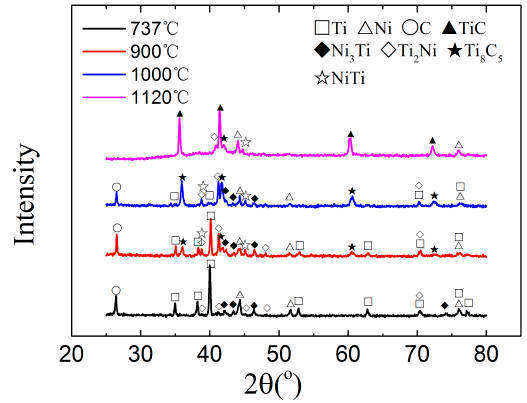
Figure 4. XRD patterns of sintered green bodies quenched at different temperatures with the heating rate of 5 °C/min.